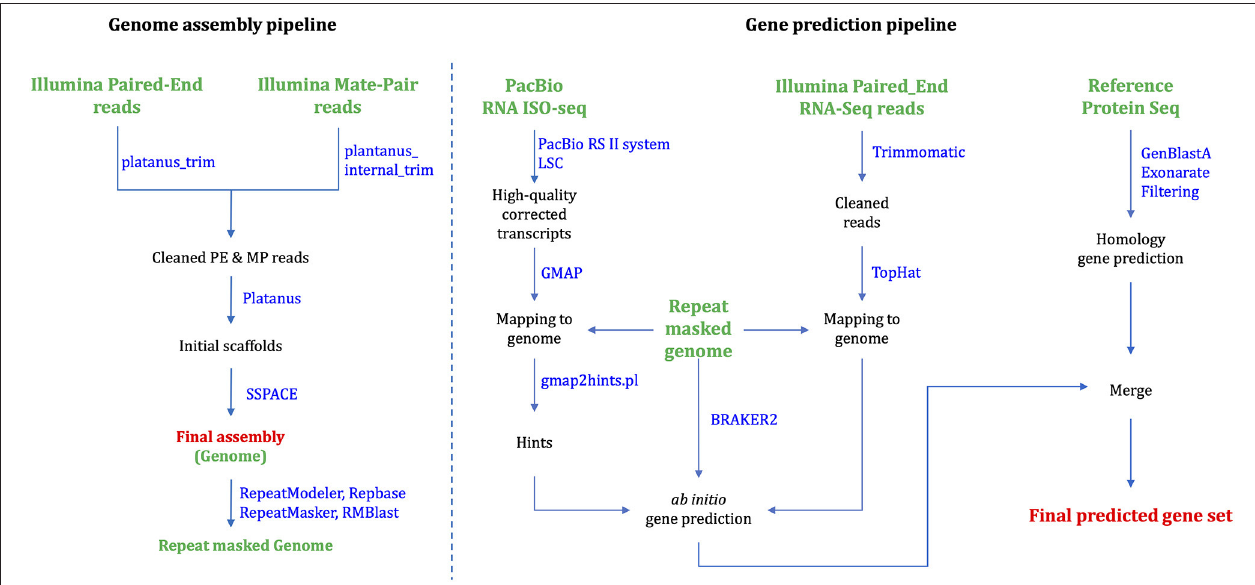
FIGURE 1 | Assembly and gene prediction workflow.